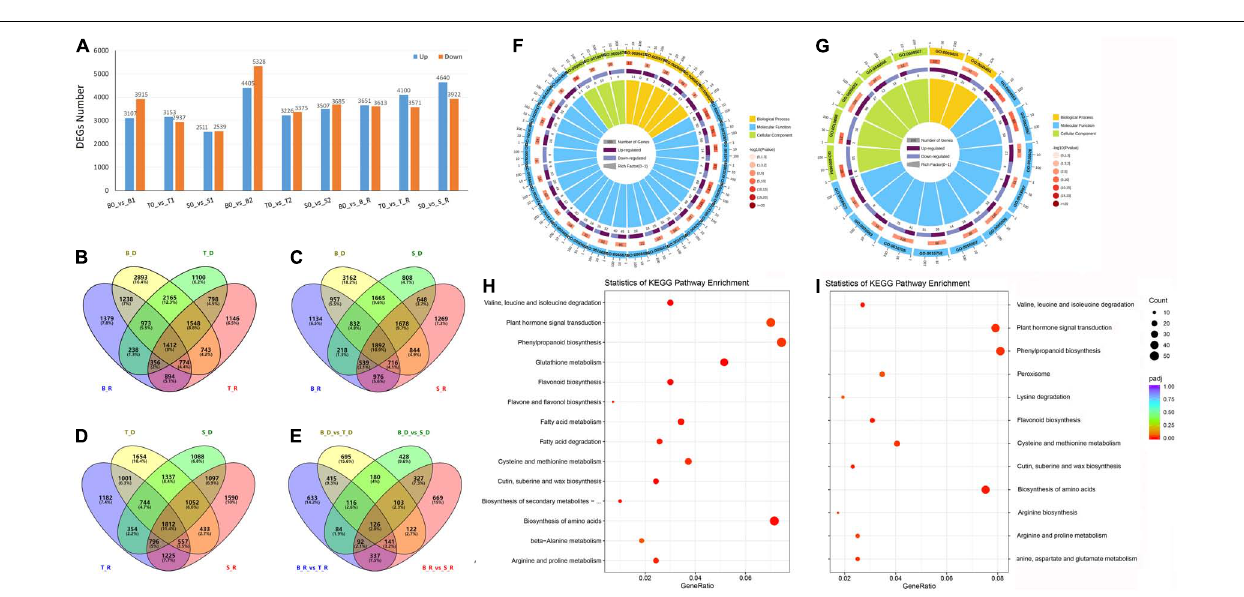
FIGURE 4 | Identification and functional annotation of DEGs in EC_S1, Tadmor and Baudin under drought treatment. (A) DEGs number; B0: 0 day of drought treatment in Baudin; B1: 14 days of drought treatment in Baudin; B2: 16 days of drought treatment in Baudin; B_R: 18 days of drought treatment and 1 days of rewatering in Baudin; S: EC_S1; T: Tadmor; Venn of DEGs in drought and rewater stage of Baudin and Tadmor (B) ; Baudin and EC_S1 (C) ; Tadmor and EC_S1 (D) Baudin_vs_Tadmor and Baudin_vs EC_S1 (E) ; B_D and B_R: DEGs of Baudin in drought and rewater treatment; S_D and S_R: DEGs of EC_S1 in drought